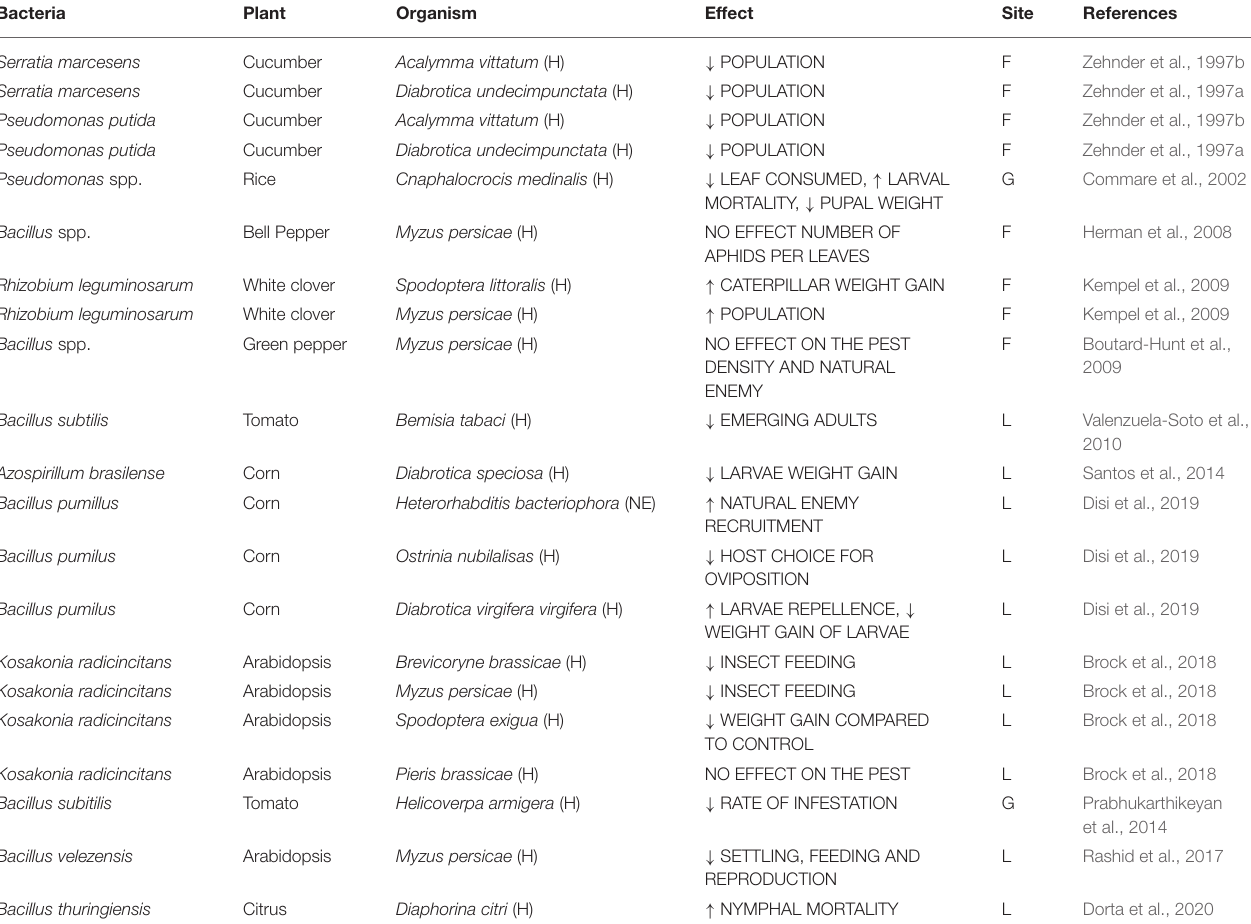
TABLE 1A | Examples of wide use of beneficial bacteria in different cultures affecting the behavioral response of insects and other natural enemies of different